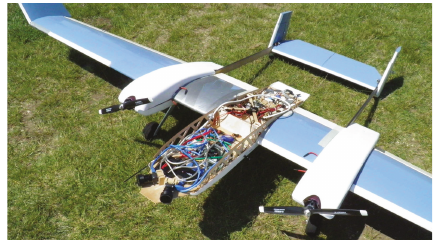
Figure 6: Sindy, twin-engine own aircraft.